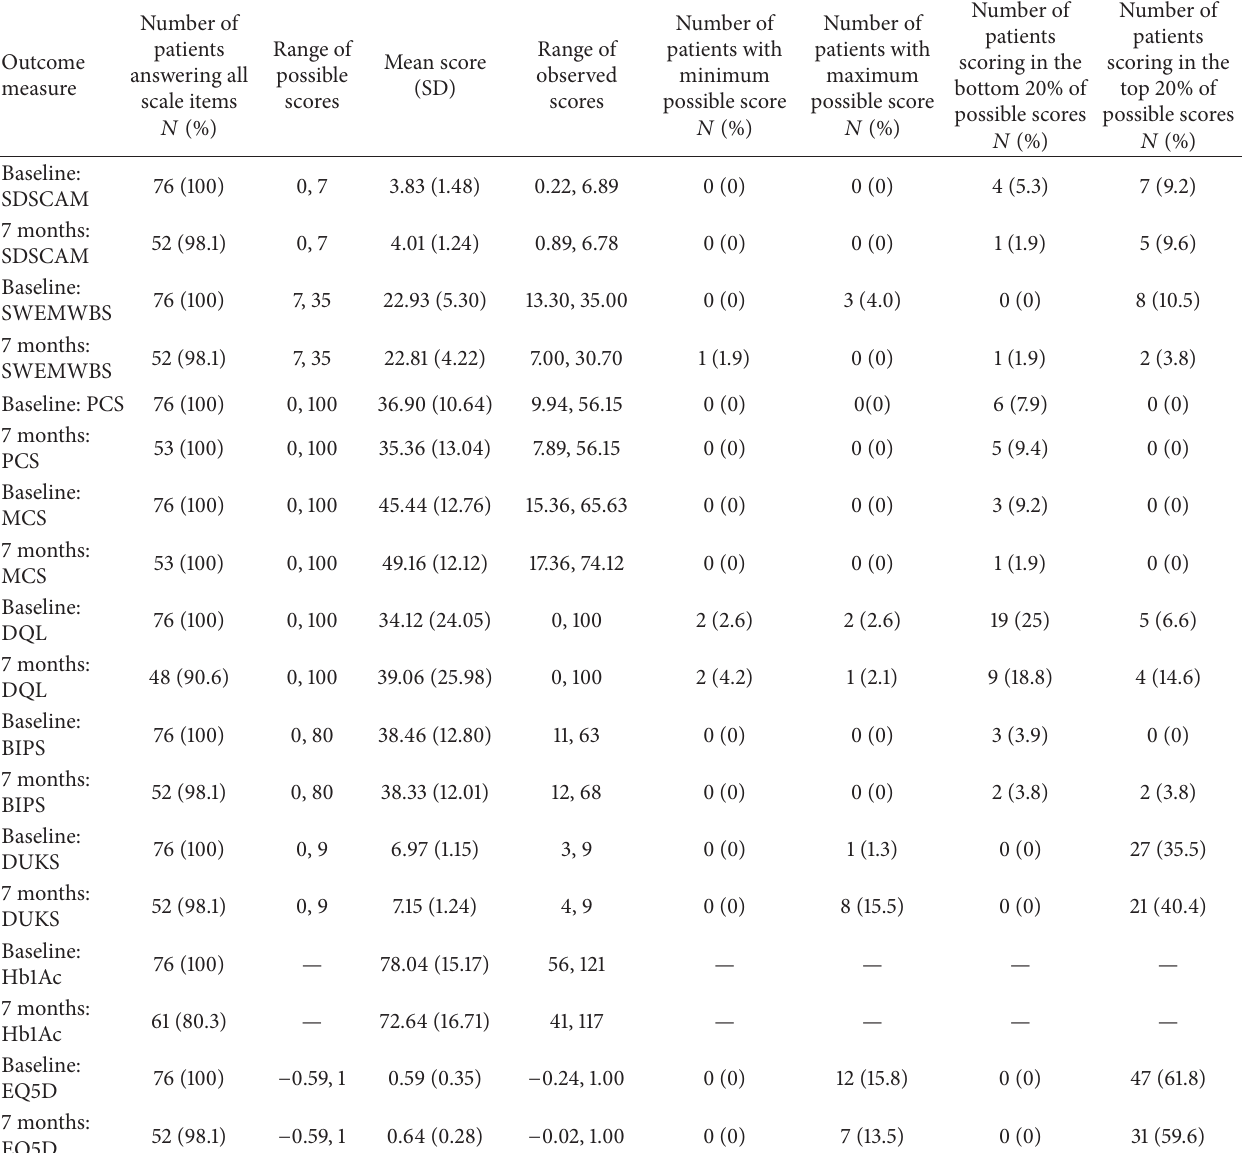
Table 2: Adequacy of outcome